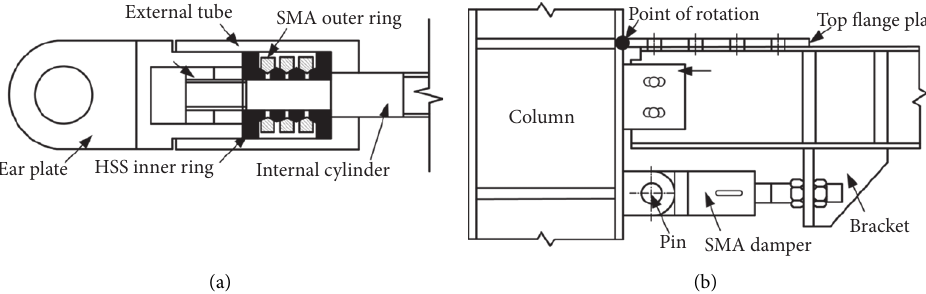
Figure 12: Details of SMA spring, damper, and connection (adapted from [51]). (a) Layout of SMA damper. (b) Layout of